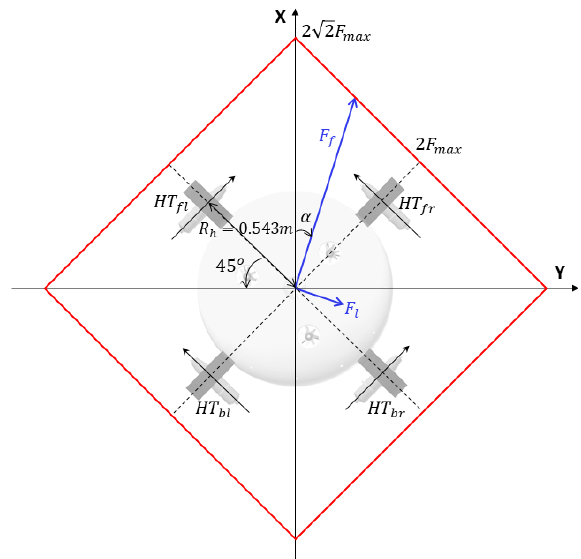
Figure 3. Horizontal thrusters arrangement and maximum vectored horizontal thrust